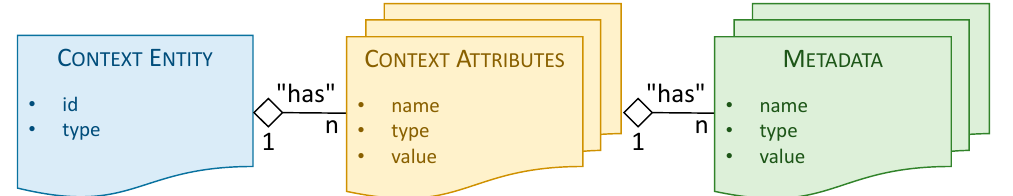
Figure 3. FIWARE NGSI context information model.